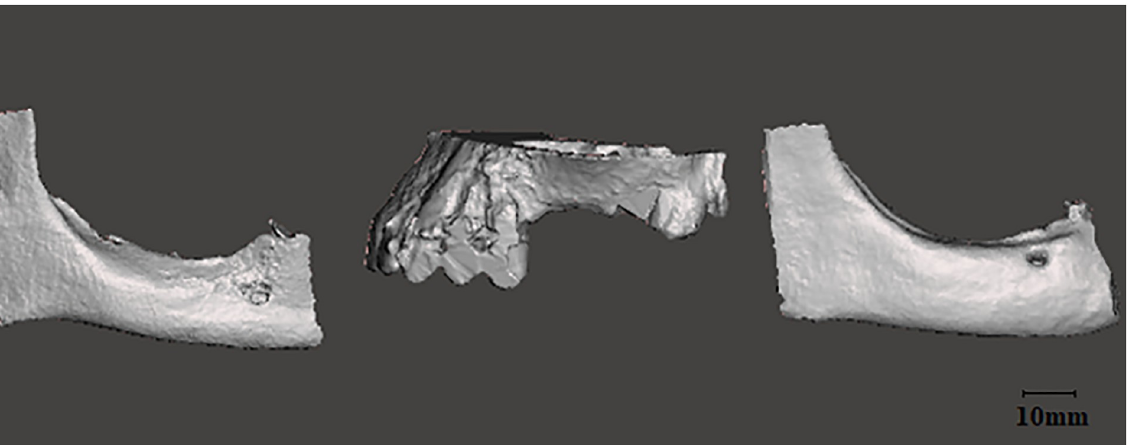
Fig 2. Group2: Lateral views of virtual 3D models with